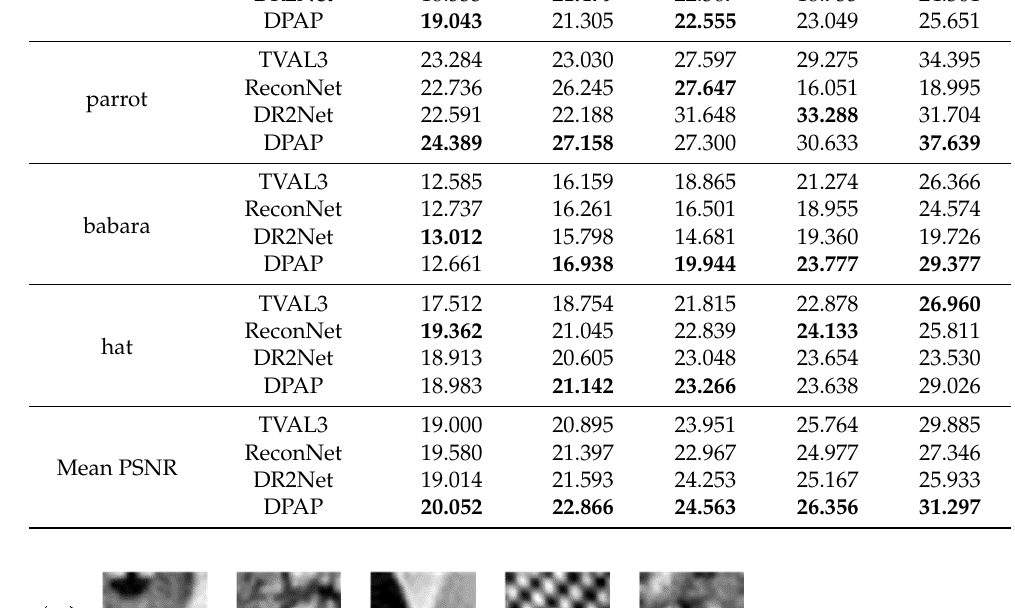
Figure 13. PSNR of test images with different algorithms at different measurement rates.